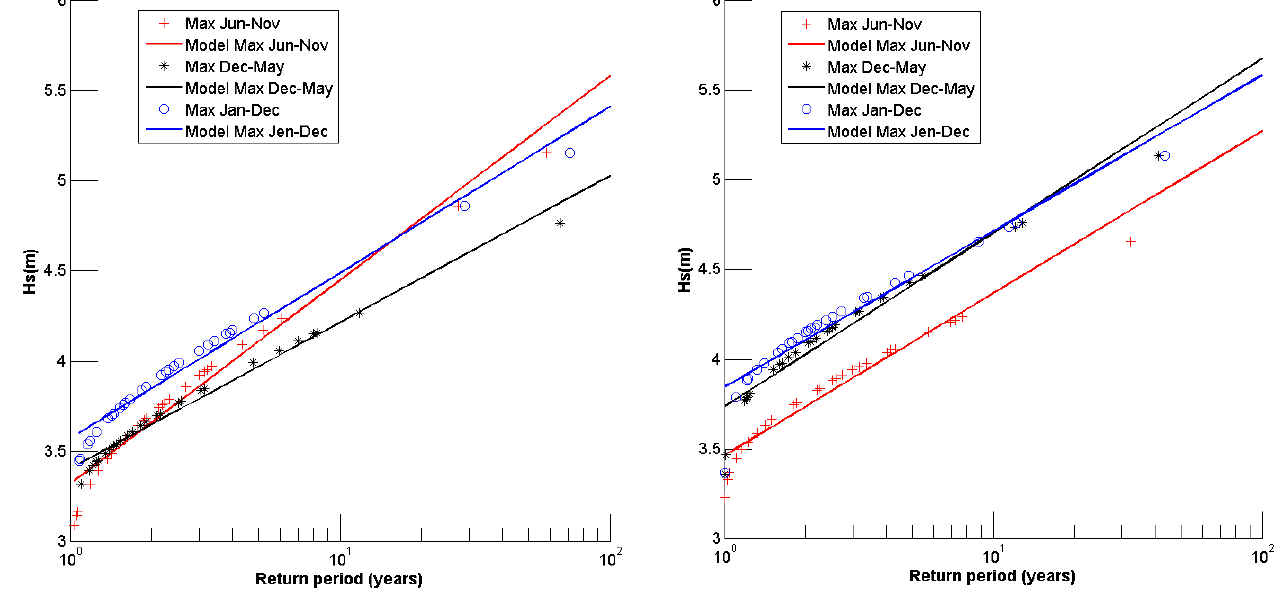
Figure 5. Comparison of the extreme wave regime in virtual buoy 01, considering the maximums of the complete series, the maxi- mums of the cold front season, and the maximums of the hurricane season.